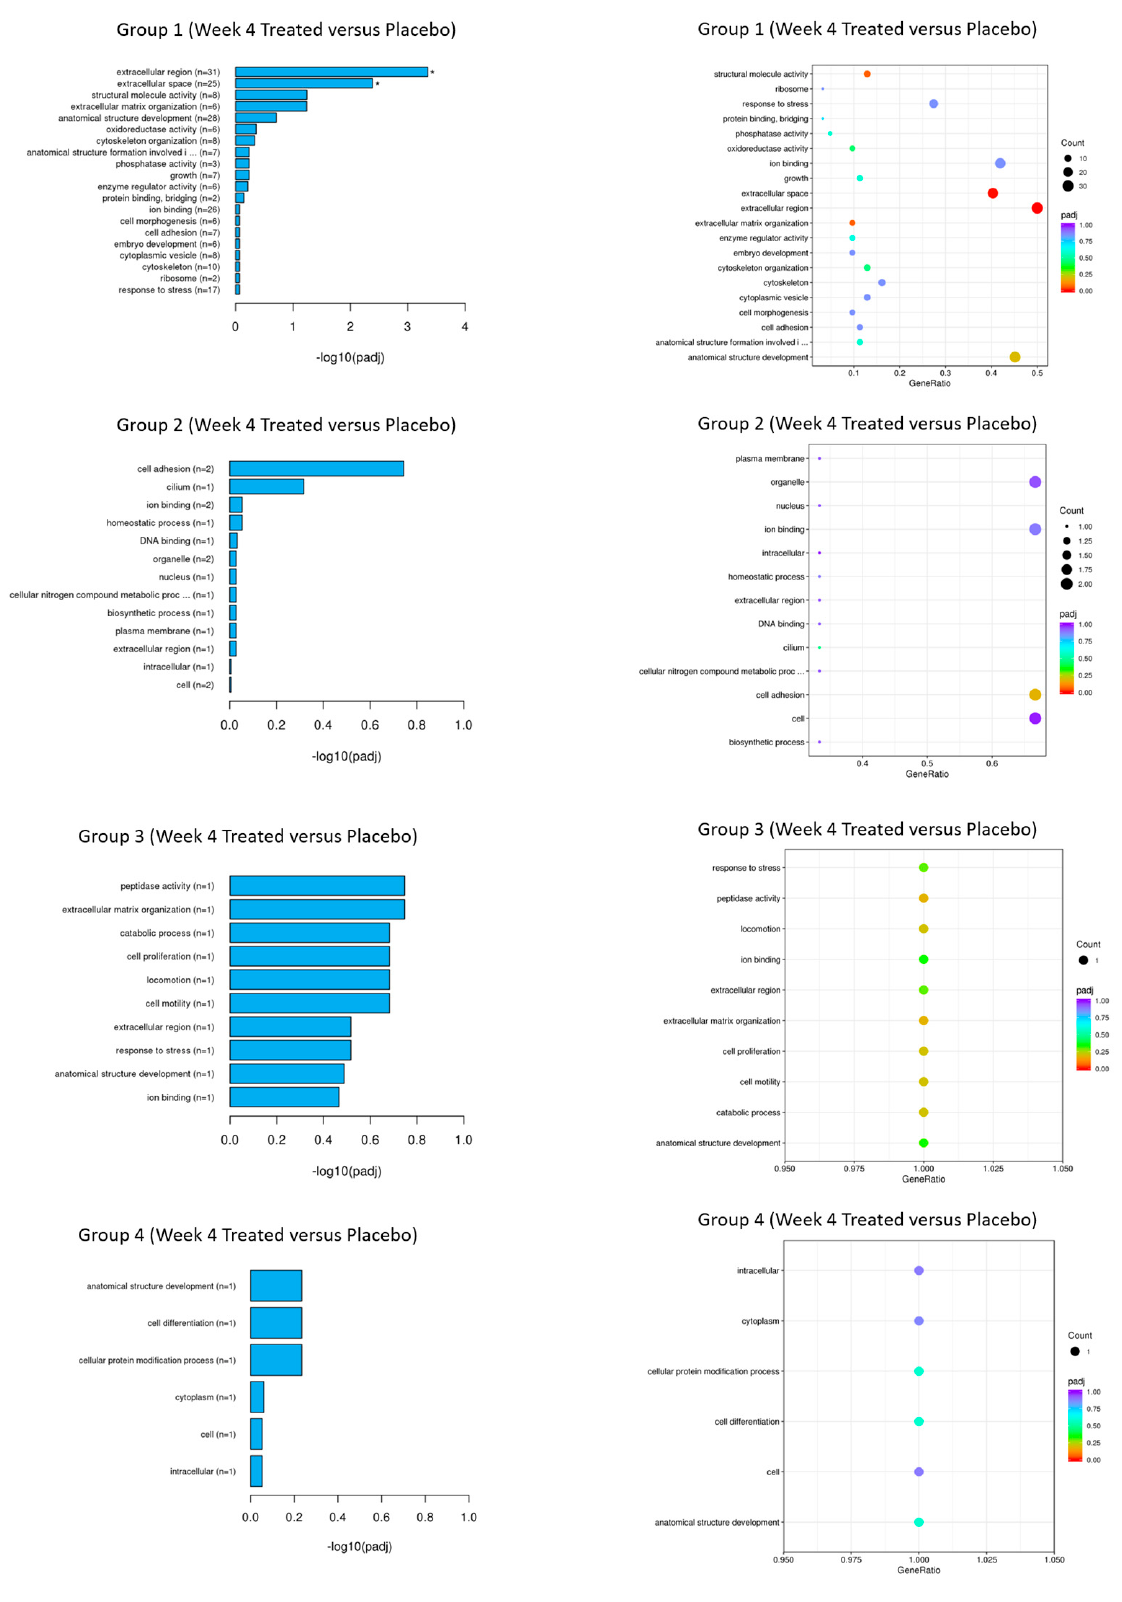
Figure 16. mRNA-sequencing results (Gene Ontology). Gene Ontology. The Gene Ontology (GO) enrichment analysis results are displayed through bar and dot plots. They display the number of genes that are significantly enriched in each GO term.